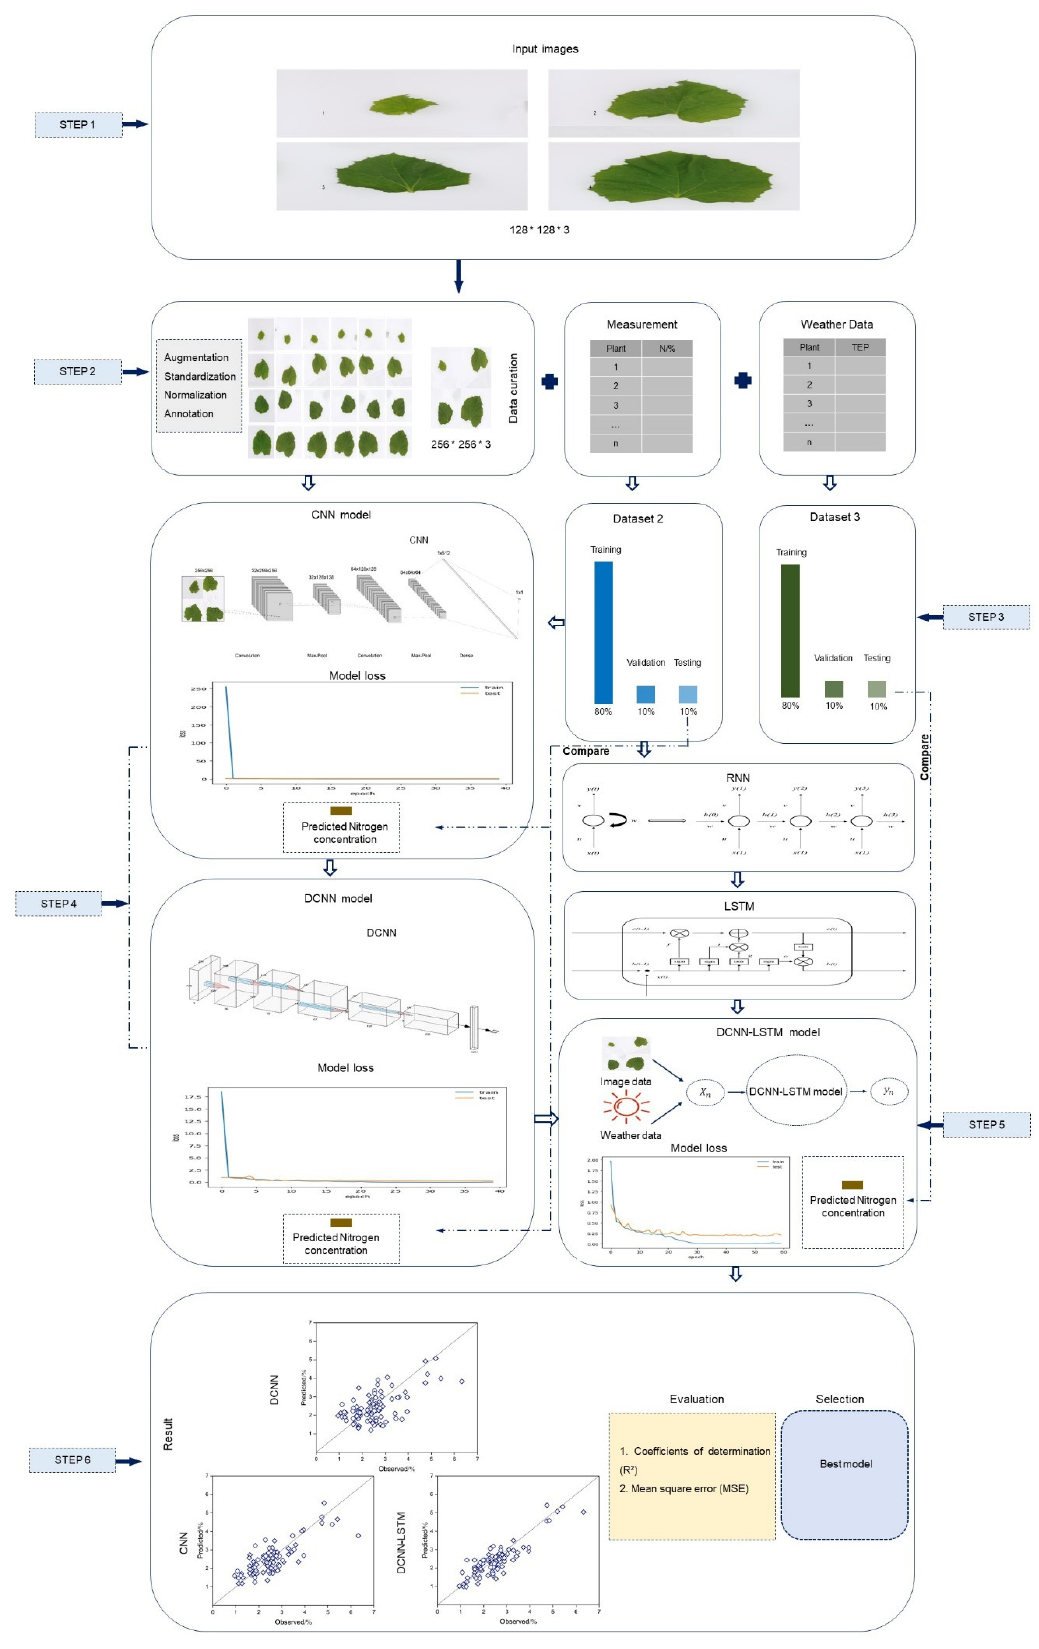
Figure 3. In Step 1, input of images into the models; in Step 2, performing data curation by augmentation, standardization, normalization and annotation; in Step 3, input the weather data and measure nitrogen (N) percentage, combine with